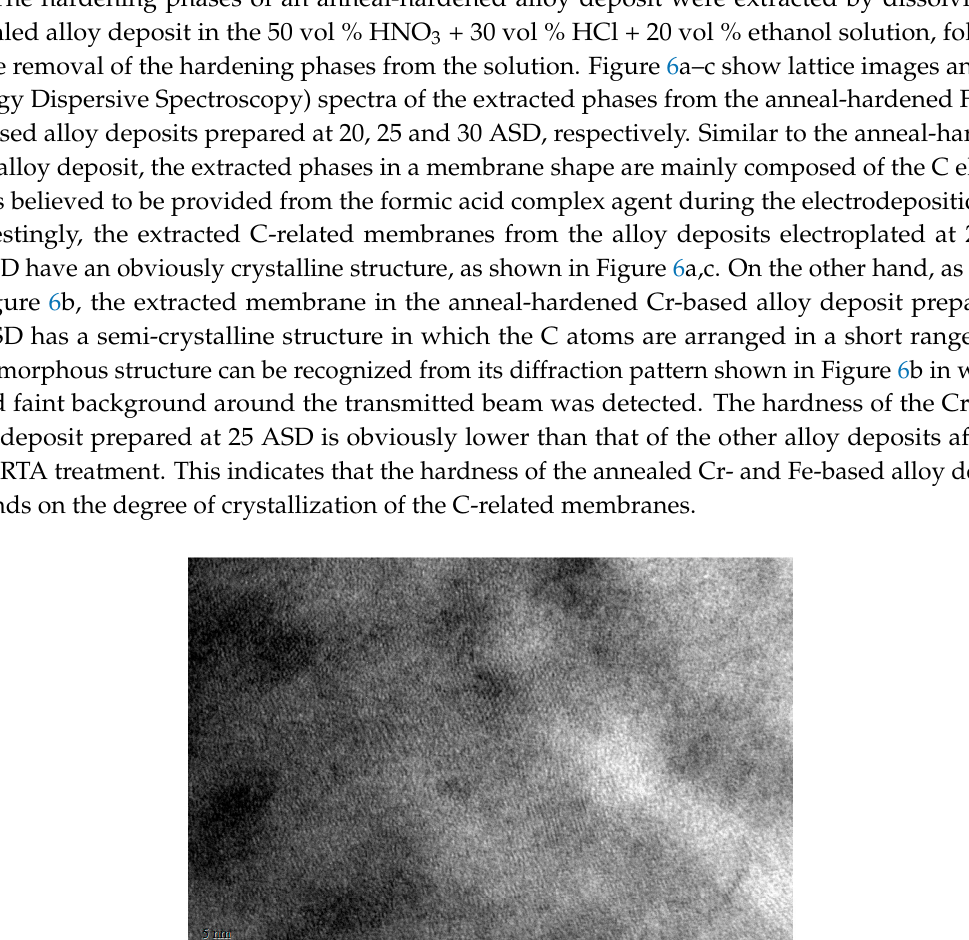
Figure 4. ( a ) Transmission electron microscopy (TEM) micrograph and electron diffraction pattern